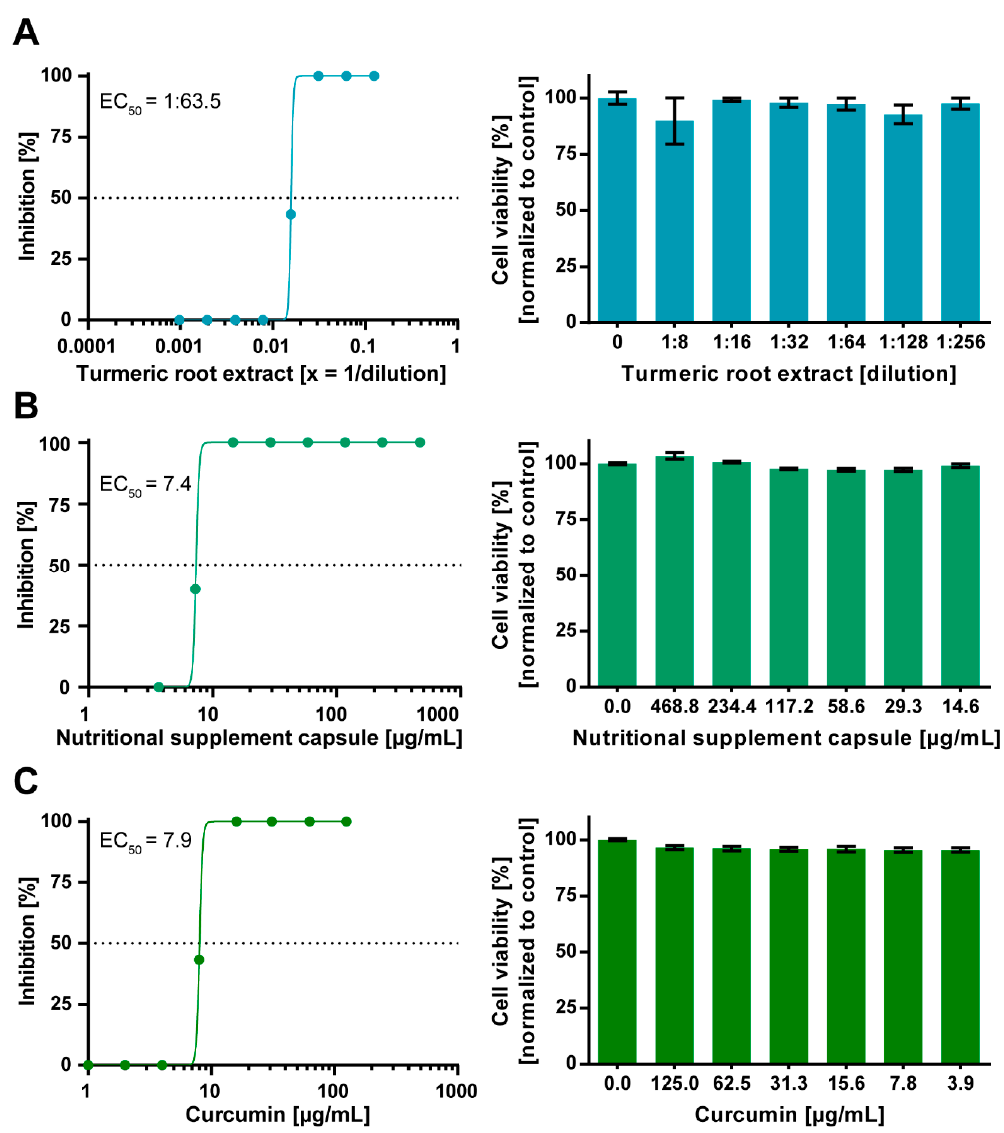
Figure 2. Dose-dependent antiviral activity of aqueous turmeric root extract, curcumin-containing nutritional supplement capsules, and curcumin against SARS-CoV-2. Decreasing concentrations of aqueous turmeric root extract (1:8–1:1024 di- lution) ( A ), nutritional supplement capsules (468.8–3.7 µg/mL) ( B ), and curcumin (125–1 µg/mL) ( C ) were pre-incubated with 100 TCID 50 of SARS-CoV-2 for one hour. Subsequently, each dilution of virus–herb suspensions was incubated on confluent Vero E6 cells grown on a 96-well plate. After 48 h, cells were stained with crystal violet and analyzed regarding cytopathic effects. The half-maximal effective concentration (EC 50 ) was calculated by nonlinear regression using GraphPad Prism. The cytotoxic effect of various concentrations of aqueous turmeric root extract, nutritional supplement capsules, and curcumin toward Vero E6 cells was determined by Orangu Cell Counting Solution (Cell guidance systems) after 48 h. Cell viability was normalized to untreated control cells. The experiment was performed three times independently. Error bars represent the standard error of the mean (SEM).